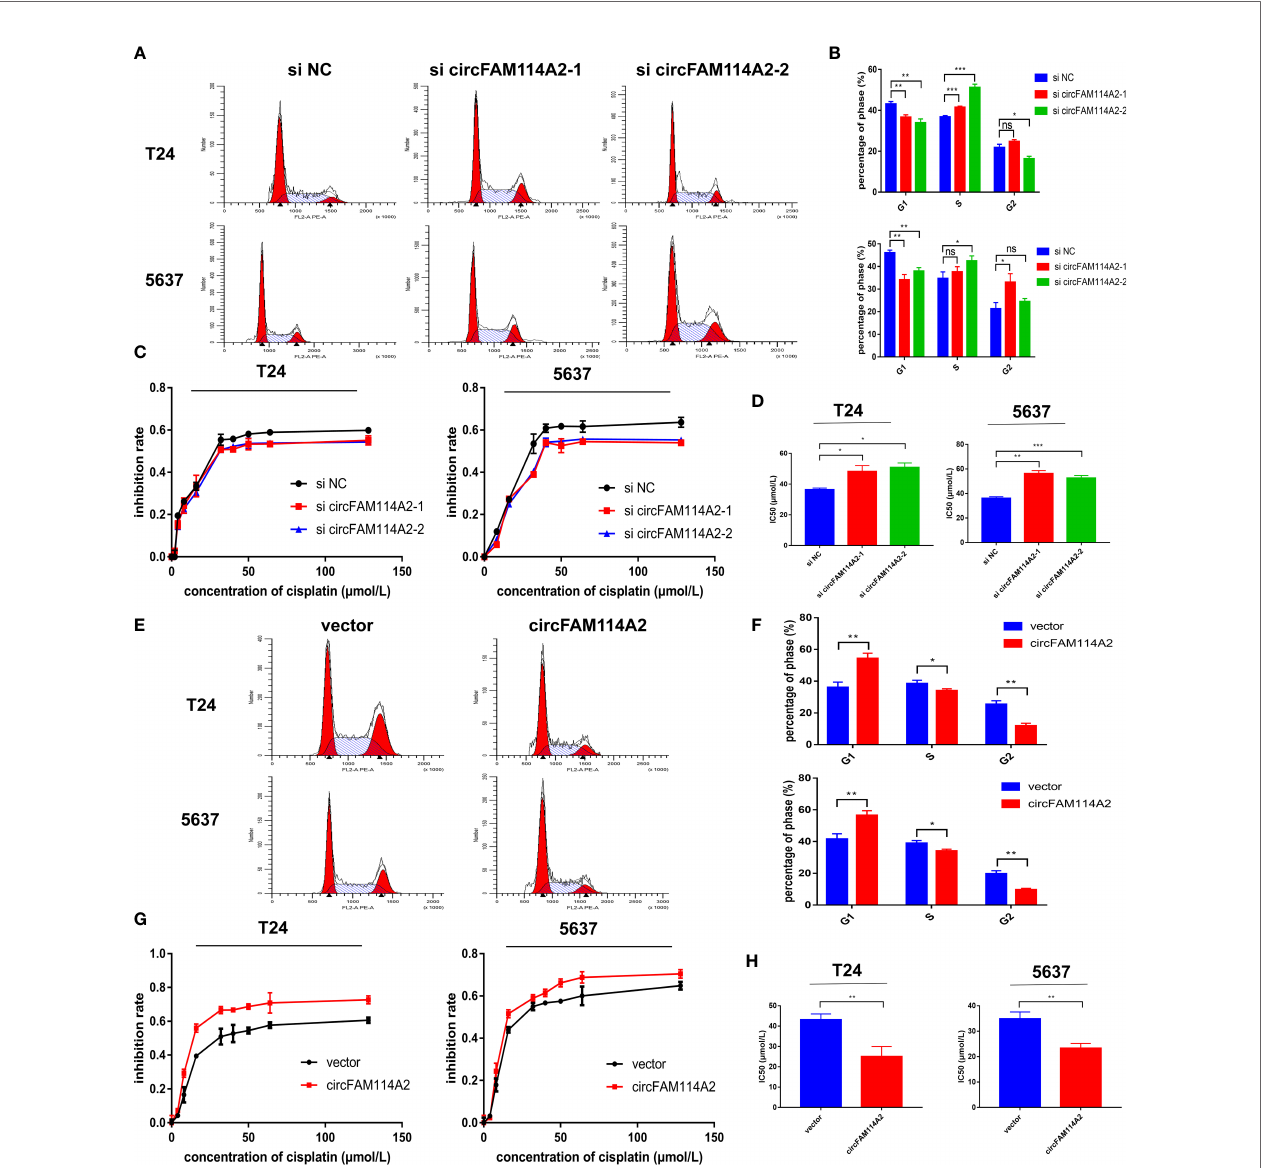
FIGURE 2 | CircFAM114A2 induced cell cycle arrest and enhanced the cisplatin chemosensitivity of urothelial carcinoma cells in vitro . (A) Illustrations of the fl ow cytometry assays in circFAM114A2 knockdown T24 and 5637 cells. (B) Fewer cells were distributed in the G1 phase and more cells were distributed in the S phase of the circFAM114A2 knockdown group compared with the control group in T24 and 5637 cell lines (Student ’ s t -test: * p < 0.05, ** p < 0.01, *** p < 0.001). ns, no signi fi cant. (C) The cell viability curve of the cisplatin treatment assays in the circFAM114A2 knockdown group and relative control group. (D) IC 50 values showed that circFAM114A2 knockdown could reduce the sensitivity of T24 and 5637 cells to cisplatin (Student ’ s t -test: * p < 0.05, ** p < 0.01, *** p < 0.001). (E) Illustrations of the fl ow cytometry assays in circFAM114A2 overexpression T24 and 5637 cells. (F) More cells were distributed in the G1 phase and fewer cells were distributed in the S phase in the circFAM114A2 overexpression group compared with the control group in T24 and 5637 cells (Student ’ s t -test: * p < 0.05, ** p < 0.01, *** p < 0.001). (G) The cell viability curveof thecisplatin treatment assays inthecircFAM114A2 overexpression group and relative control group. (H) IC 50 values showed that the overexpression of circFAM114A2 could increase thesensitivity of T24 and5637 cells to cisplatin(Student ’ s t -test: ** p < 0.01, *** p < 0.001).Data are the mean± SD, n =